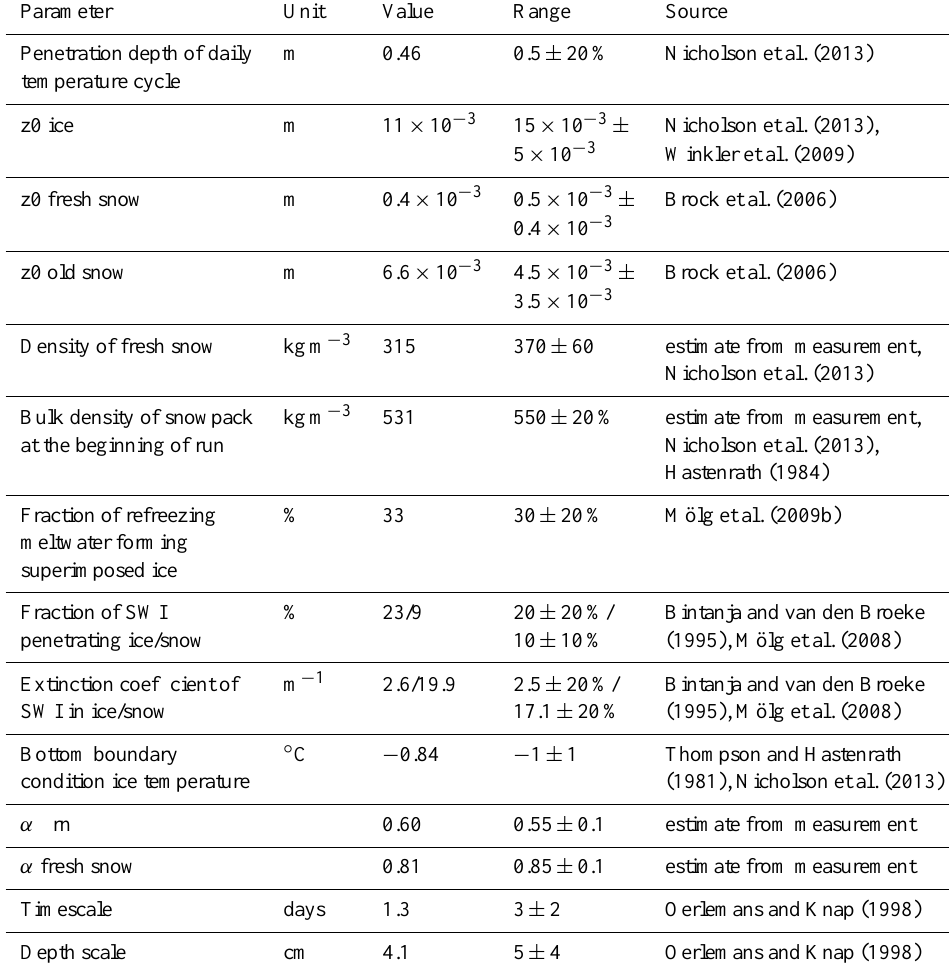
Table 2. Input parameters for the MBM showing the optimized value and the range permitted in the Monte Carlo simulation. Some parameters may differ from Nicholson et al. (2013), due to the use of a different model version employing parametrizations of sensitive model inputs such as albedo. Fresh snow density was obtained by in situ sampling, and similar values around 300kgm − 3 were previously reported for topical mountains in Bolivia and Tanzania (Mölg et al., 2008; Sicart et al.,